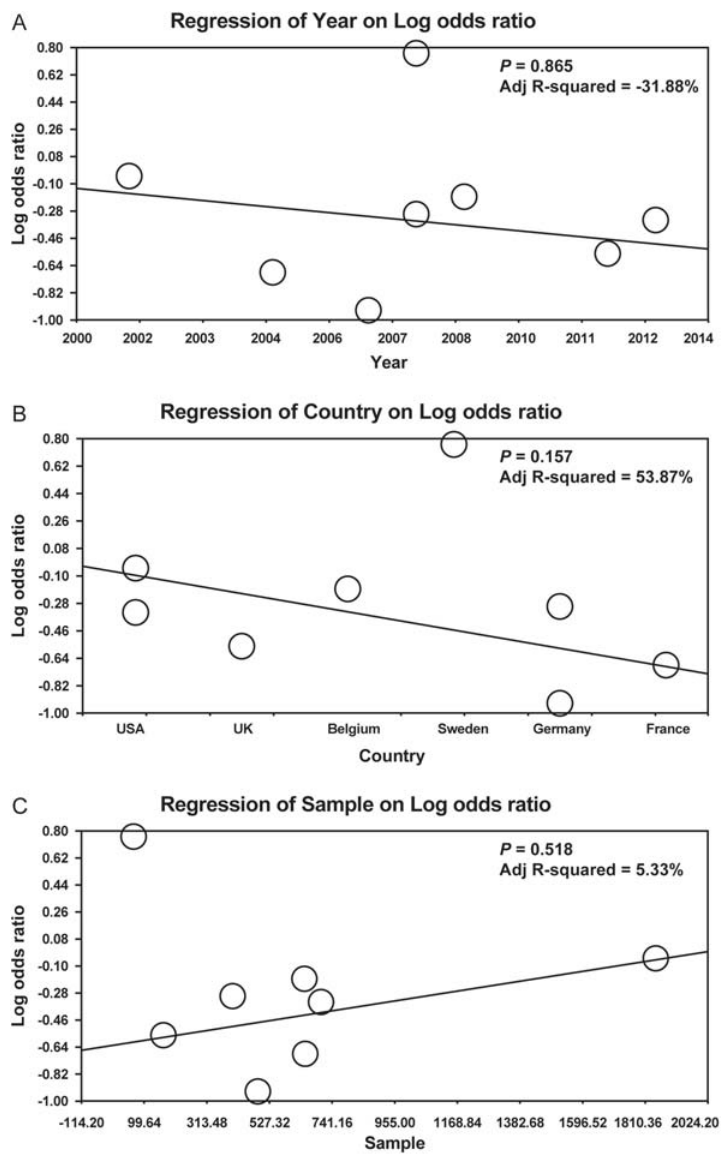
Figure 5. Meta-regression analyses of the in fl u- ence of high- fl ux hemodialysis and low- fl ux hemo- dialysis on the all-cause death rate of patients with chronic renal disease by year, country, and sample. See Table 1 for reference